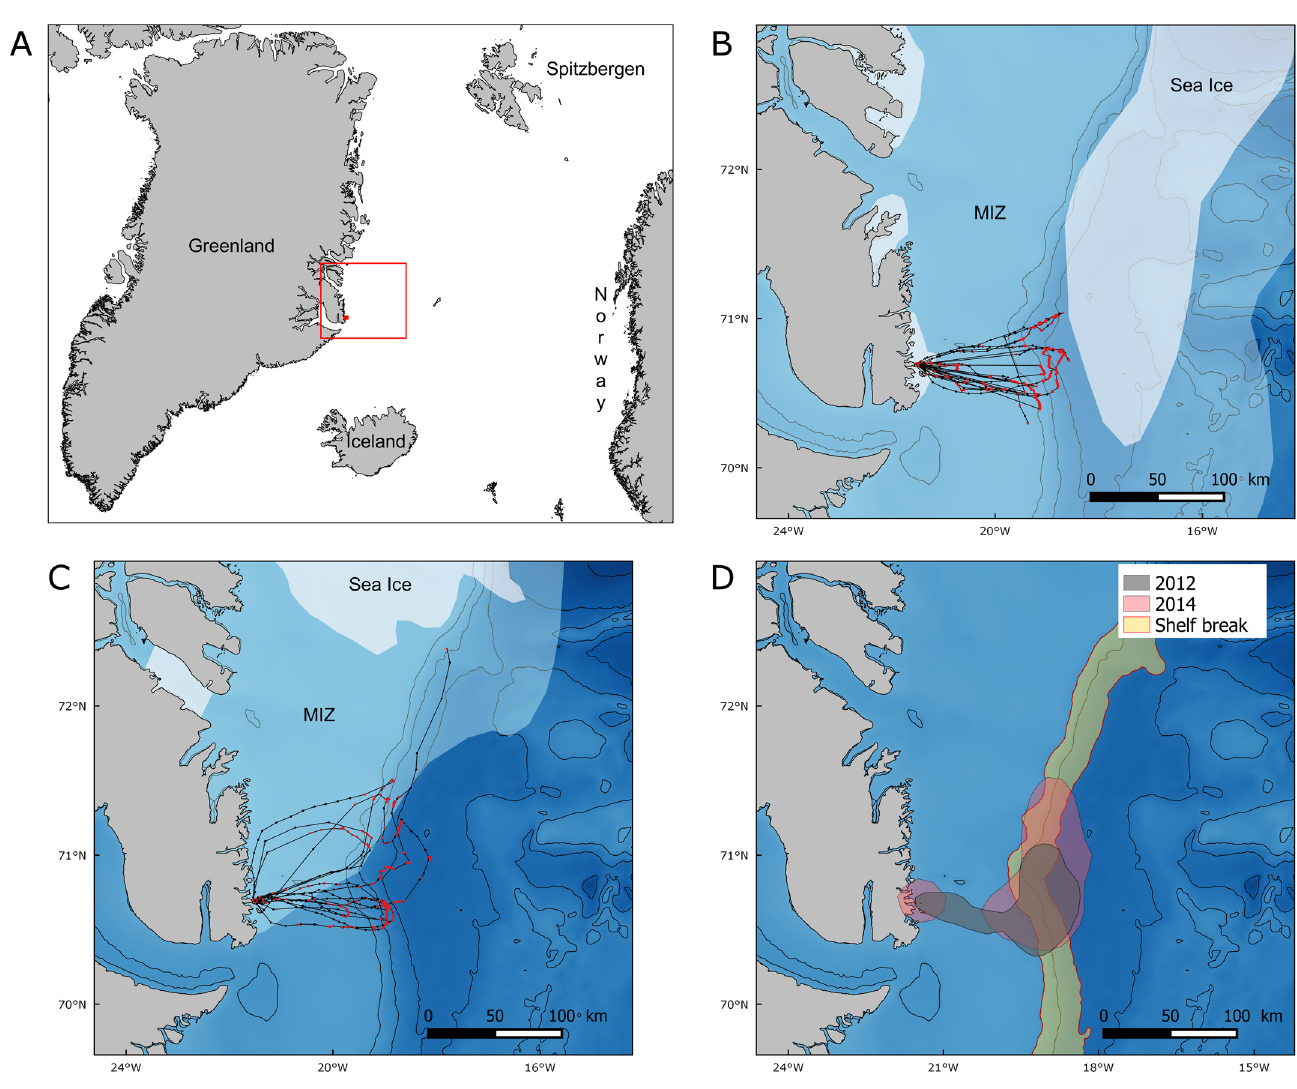
Fig 1. (A) Location of the study site, sea ice extent and GPS tracks from (B) 2012 and (C) 2014 and (D) 75% kernel contours of resting and foraging positions in 2012 (green), and 2014 (pink), and the shelf break area (yellow). 1A: General map situating Ukaleqarteq (red dot) and the location of the studied area (red rectangle) represented in Figs 1B, 1C, 5A and S1. 1B and 1C: GPS tracks: red dots correspond to foraging or resting (speed < 10 km.h -1 ) and black dots to travelling (speed > 10 km.h -1 ). Sea ice extent data were downloaded from the U.S. National Ice Center (http:// www.natice.noaa.gov/products/daily_products.html, 24 July 2012 and 23 July 2014). White: pack ice with an ice concentration > 80%. Light blue: marginal ice zone (MIZ) with an ice concentration < 80%. In the marginal ice zone, sea ice concentration decreased between pack ice and open water. Black lines: 500-m isobaths. GPS track of the bird going far North-East in 2014 was not included in the analyses because it was not complete, but we present it on this map to show how this bird travelled along the shelf break and probably target areas of high ice concentration. 1D. Red lines represent the 500 and 1500m isobaths used to delimit the shelf break area. Projection: GR96/ UTM zone